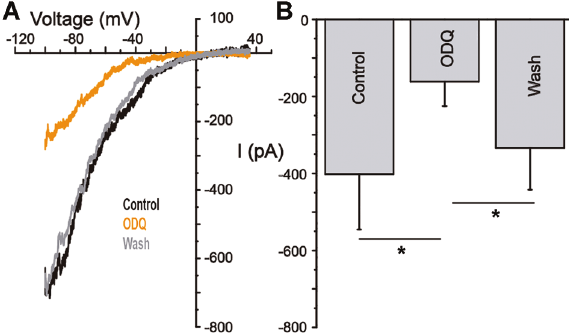
Figure 5. cGMP modulated purinergic currents. A , I (cid:2) V relation- ship for ATP-evoked currents in control condition (black), after 10 min ODQ incubation (orange), and after washing with Hank ’ s solution (gray). The bar graph in B shows the mean ± SE amplitude for the currents measured at – 70 mV. Note the signi fi cant amplitude decrease after ODQ incubation and its recovery after washing with Hank ’ s solution. *P p 0.05, n=5 cells (ANOVA and Tukey